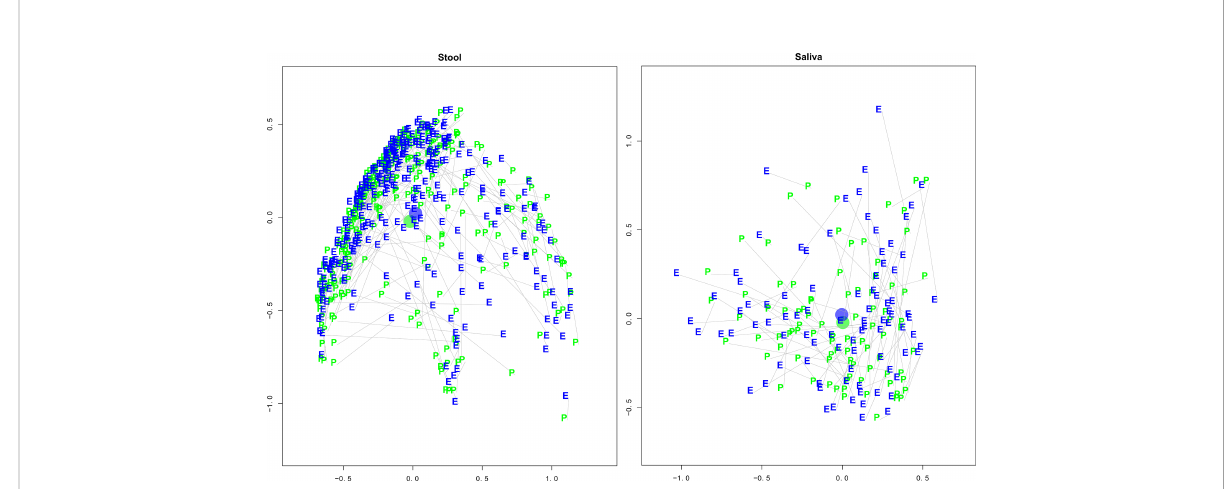
FIGURE 2 Stool and Saliva Pre- and Early Pandemic Paired MDS plots. These multi-dimensional scaling (MDS) plots illustrate each subject ’ s taxonomic compositional similarity between pre- and early pandemic samples in context with the samples of the cohort. The left and right panels represent the intra-cohort separation of stool and saliva samples, respectively. The green “ pre ” and blue “ early ” labels indicate the MDS estimated locations of pre- and early pandemic samples, respectively. A grey line connects pre- and early pandemic samples from the same subject. The blue and green circles represent the centroids of the pre- and early pandemic samples. After controlling for questionnaire responses, the bootstrapped regression identi fi ed that pre- vs early pandemic samples had a statistically signi fi cant separation (coef = 1.1404, p- val < 0.0001), but saliva did not (coef = 0.1421, p-val =